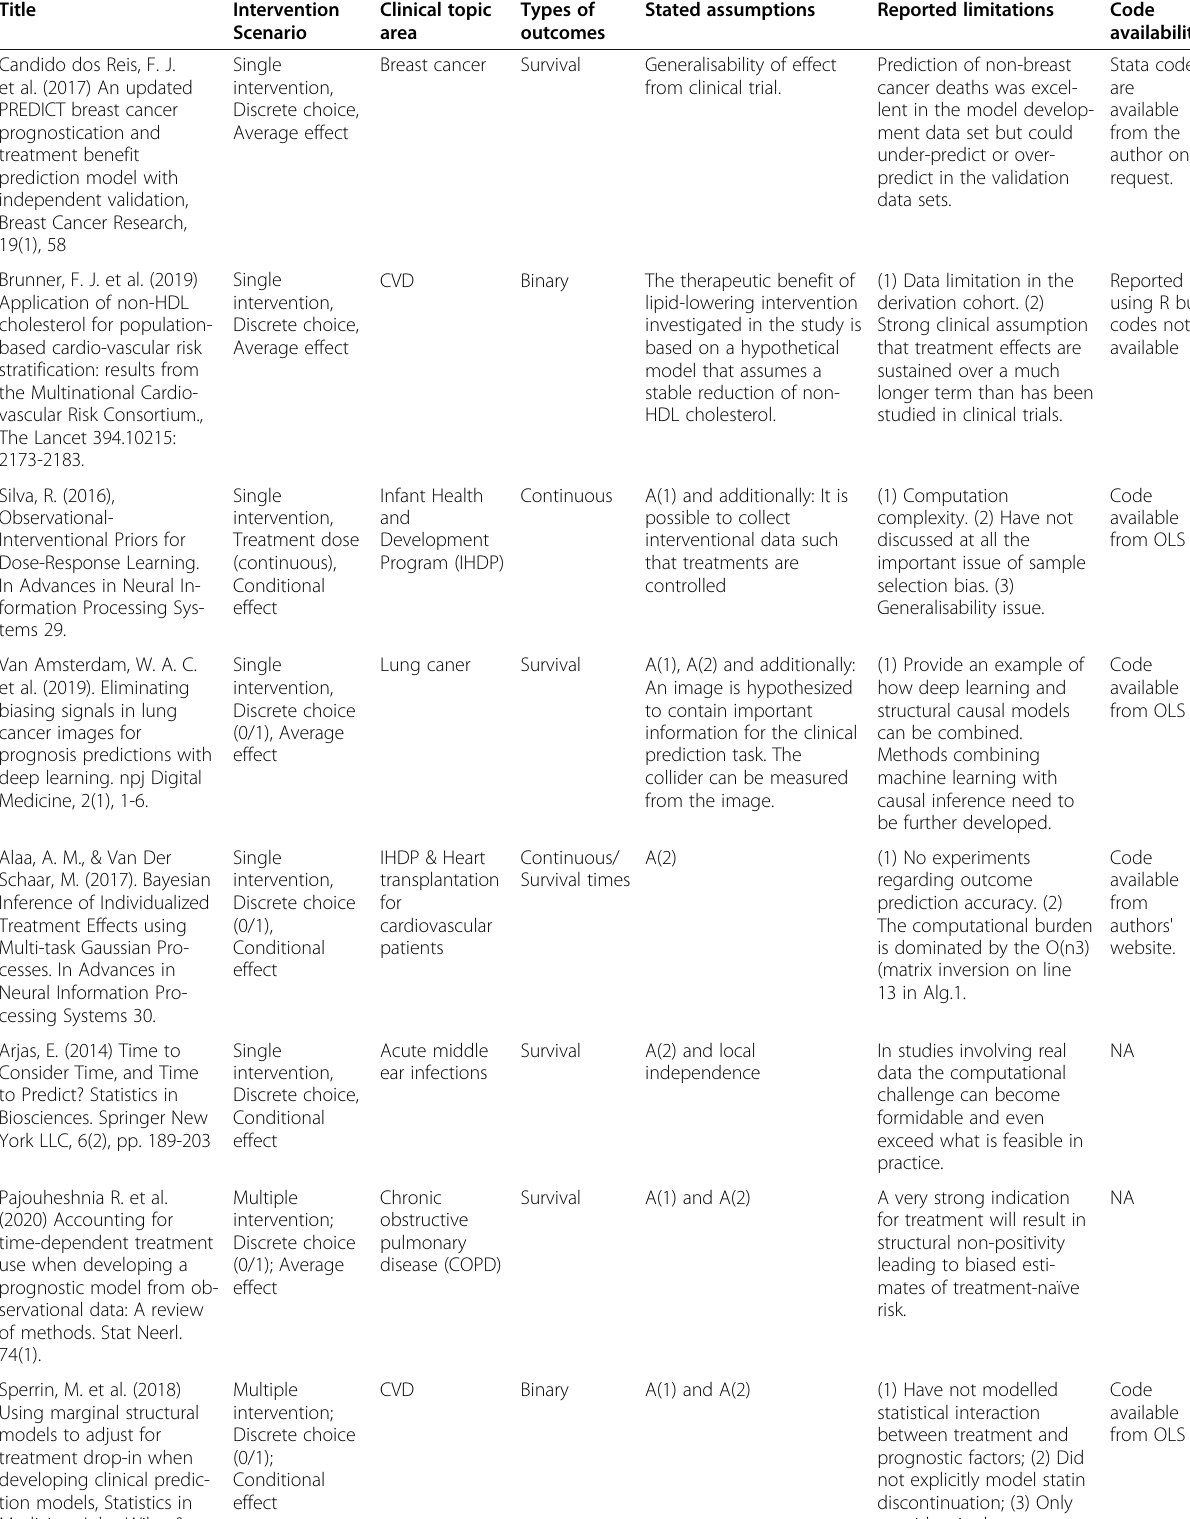
Table 1 Summary of included 13 papers (See Supplementary File 1 for the completed extraction